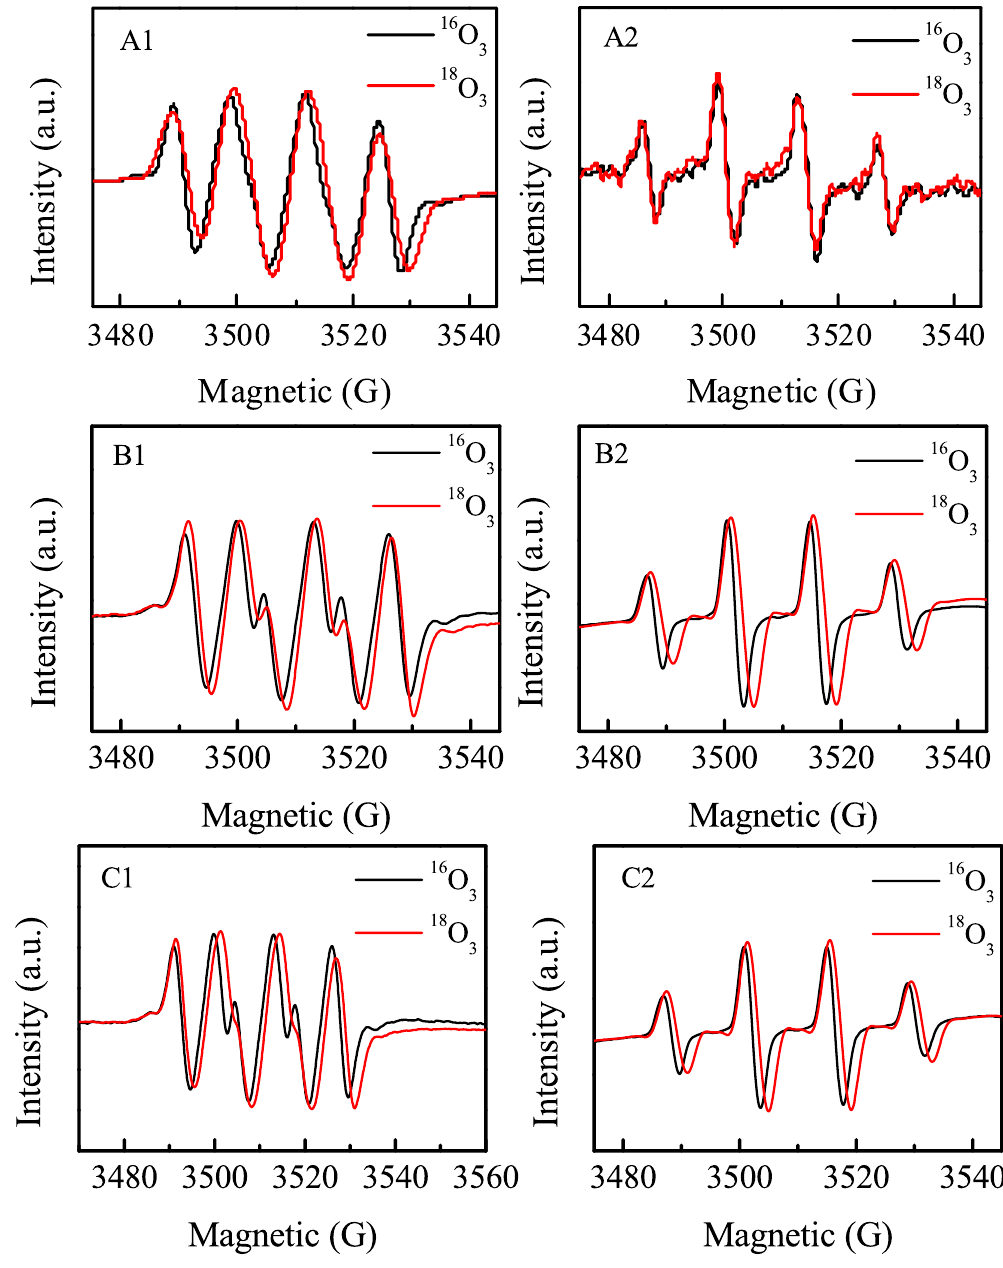
Figure 7. EPR spectra of O 3 alone ( A ), α -FeOOH ( B ) and Fe 3 O 4 ( C ) recorded in methanol dispersion for BMPO-HO 2 • /O 2 •− (A1, B1 and C1) and aqueous dispersion for BMPO- • OH (A2, B2 and C2) with 16 O 3 or 18 O 3